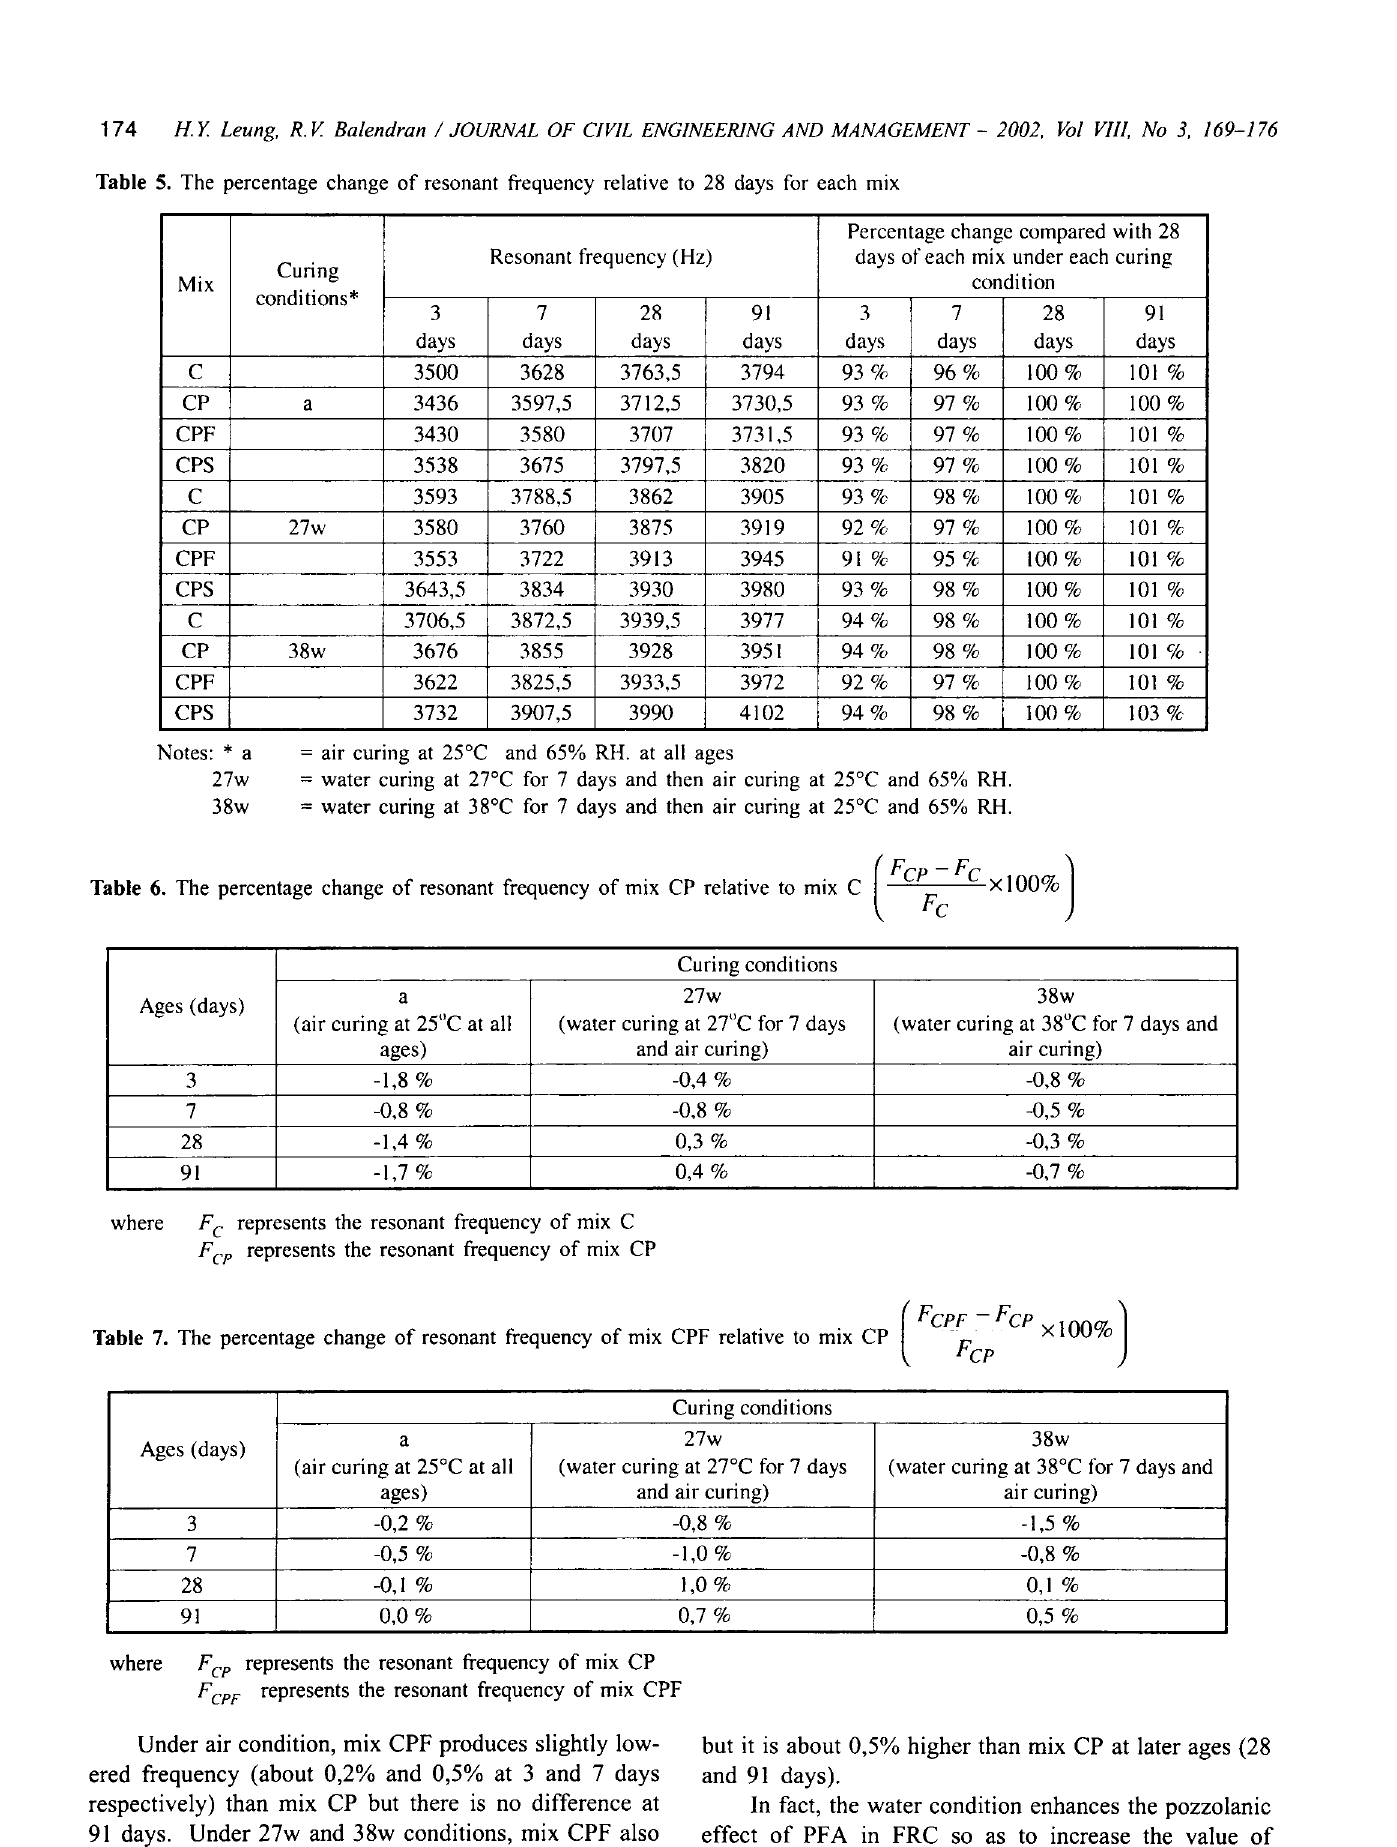
Table 7. The percentage change of resonant frequency of mix CPF relative to mix